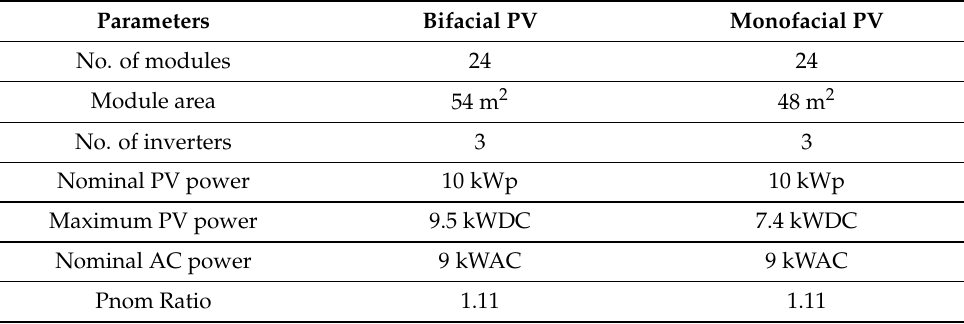
Table 2. Simulation